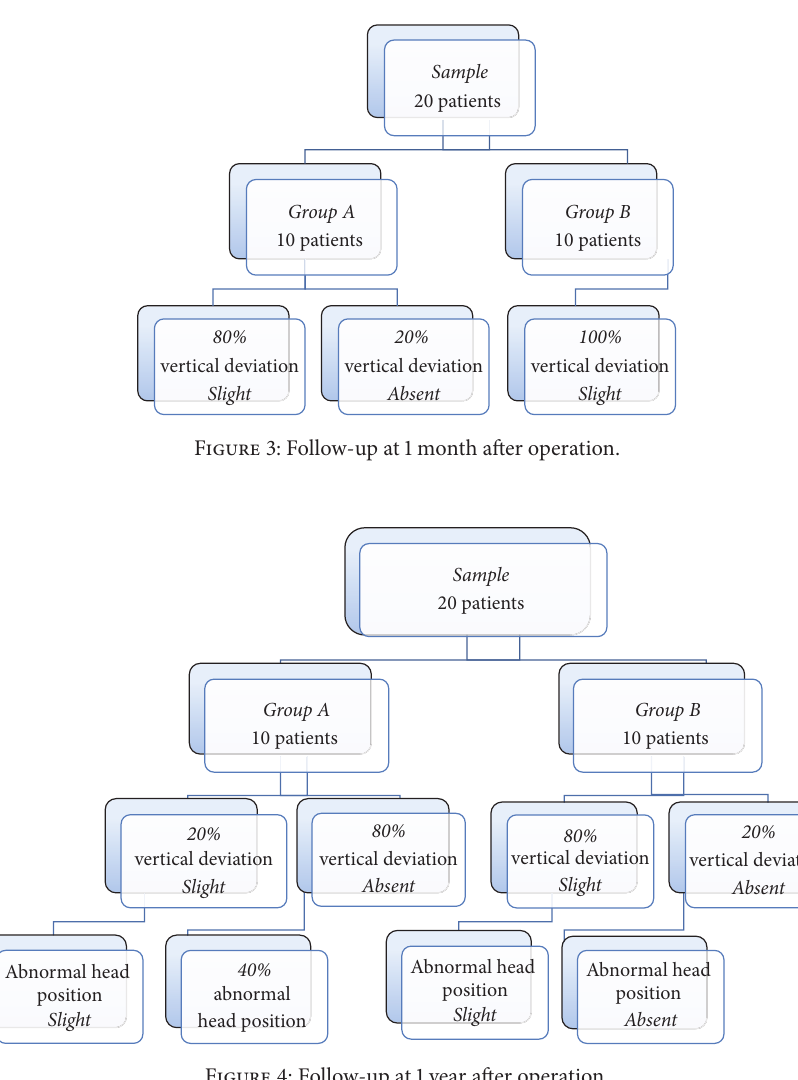
Figure 4: Follow-up at 1 year after